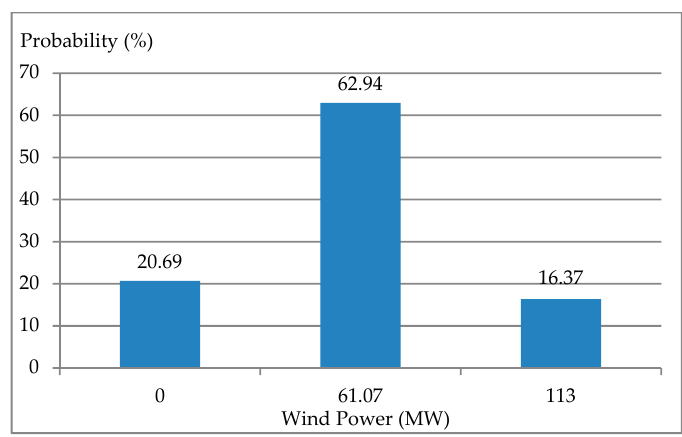
Figure 1. Three ‐ point discrete distribution of wind power.